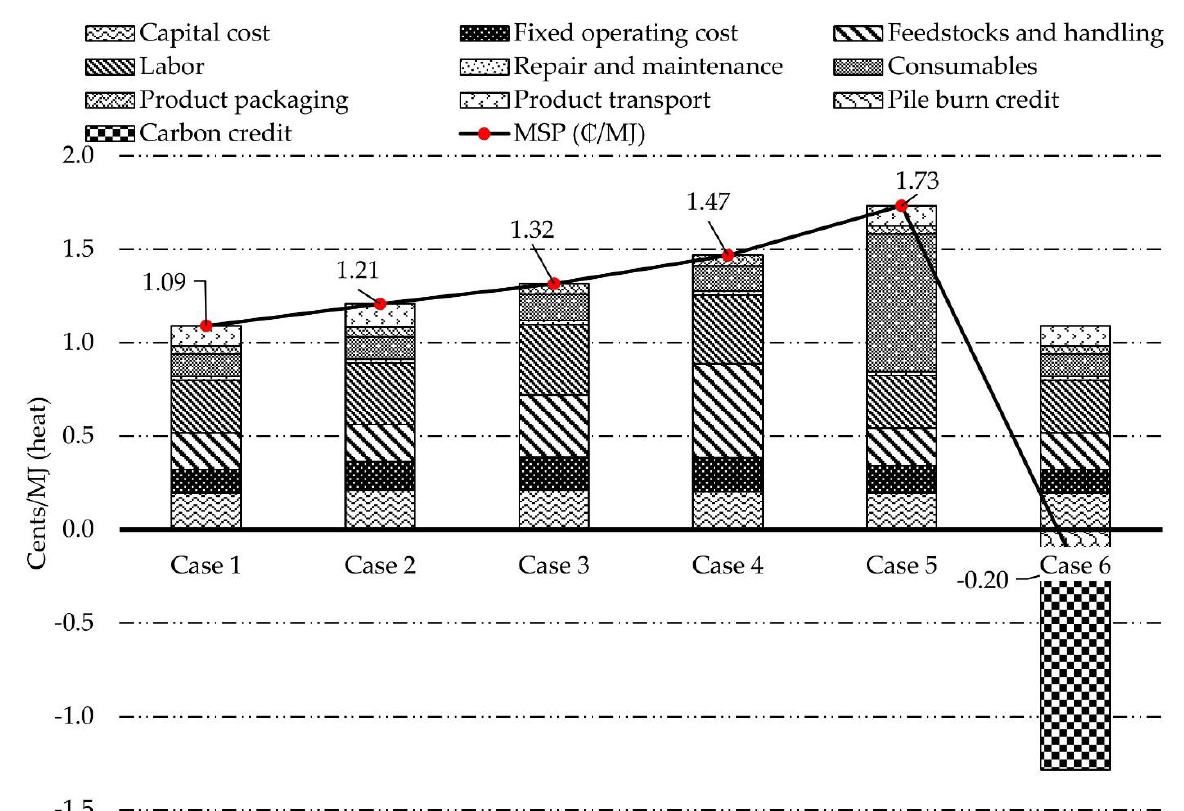
Figure 6. Comparison of minimum selling price (MSP) per 1 MJ of heat generated using wood briquettes and contributions of various cost inputs to MSP in six cases. Case 1: near-woods operation with wood biomass gasifier power; Case 2: near-woods operation with diesel power; Case 3: in-town operation (2 h travel distance) with grid power; Case 4: in-town operation (4 h travel distance) with grid power; Case 5: 50% moisture content feedstock, near-woods operation with wood gasifier power; Case 6: near-woods operation with wood gasifier power with pile and burn credit.